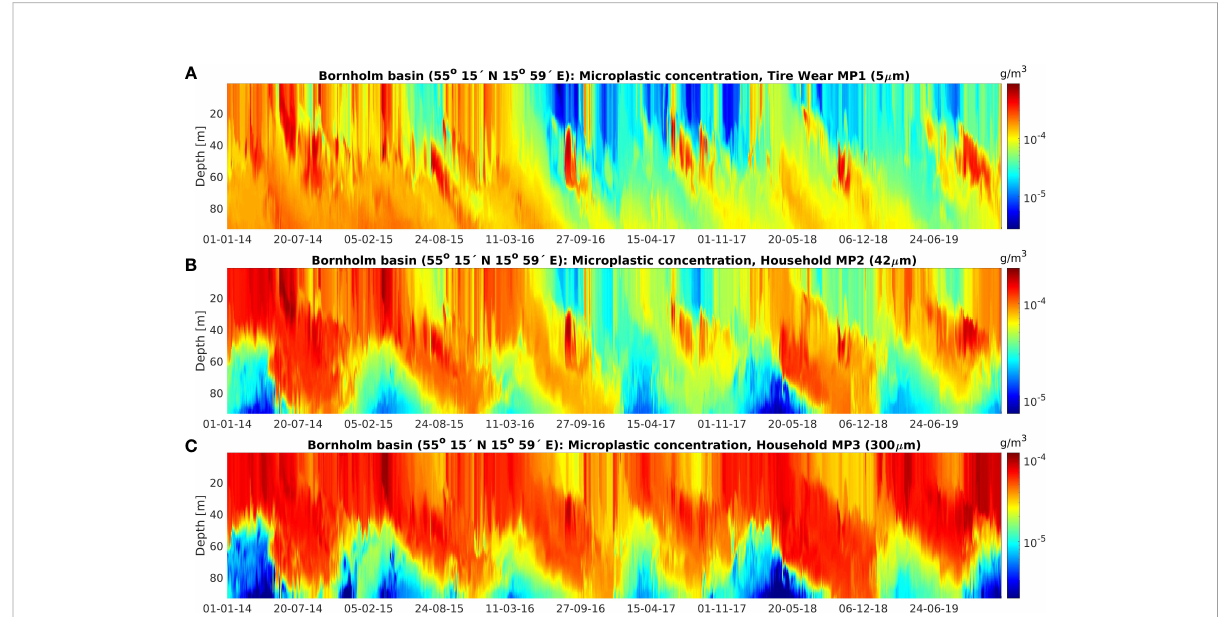
FIGURE 5 Pro fi les of microplastic concentration for tire wear MP1 (A) , household microplastics MP2 (B) and MP3 (C) fragments at Bornholm deep, station BMPK2 (55° 15 ’ N 15° 59 ’ E), in the southern Baltic